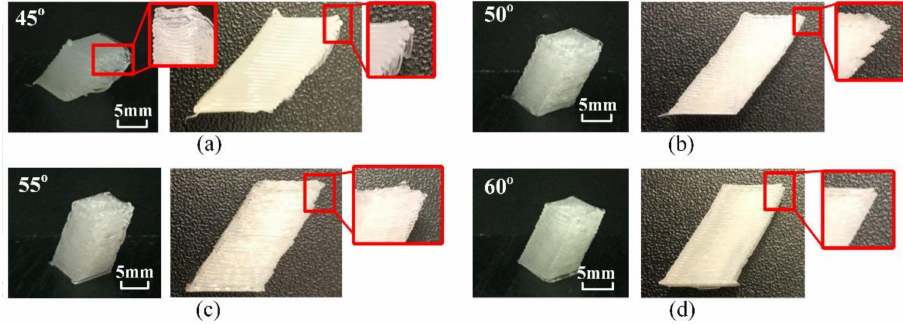
Figure 6. Samples printed with different overhang angles ( a ) 45 ◦ , ( b ) 50 ◦ , ( c ) 55 ◦ , and ( d ) 60 ◦